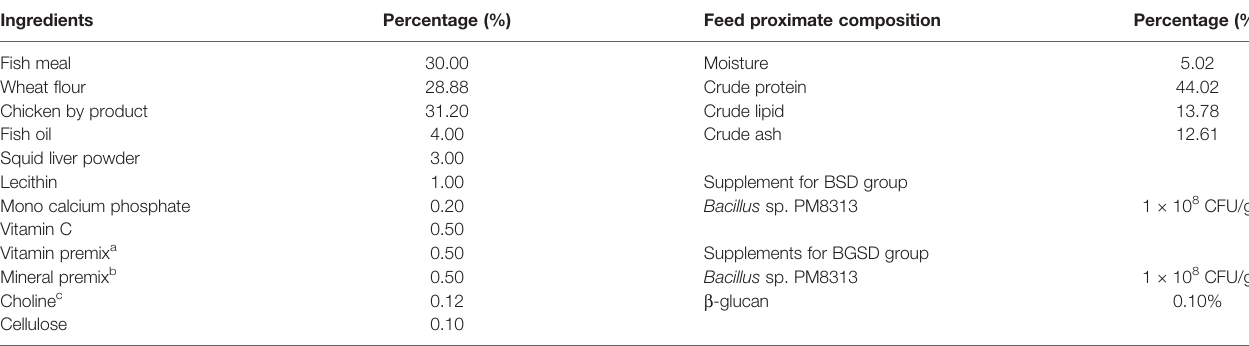
TABLE 1 | Composition of the basal experimental diet for red sea bream ( Pagrus major ). Ingredients Fish